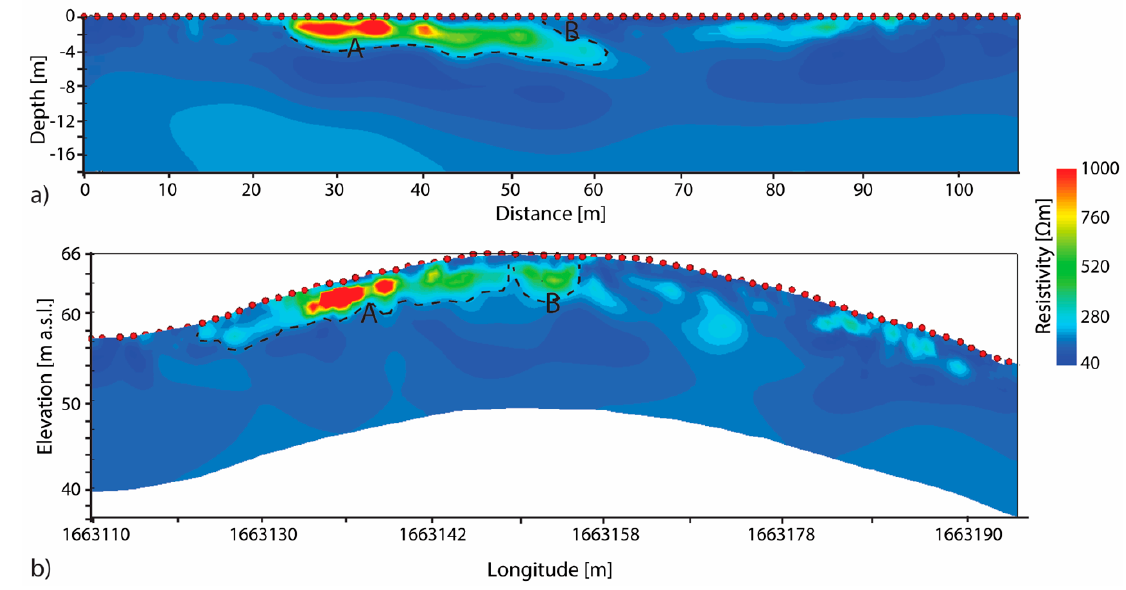
Figure 4. T1-ERT resistivity profiles obtained inverting at the same time DD and PD acquired data. ( a ) ERT profile obtained without take into account the topography (flat) and ( b ) taking it into account. Anomaly A and B can be associate to the dromos rocky blocks and the shadow of the funeral chamber, respectively.